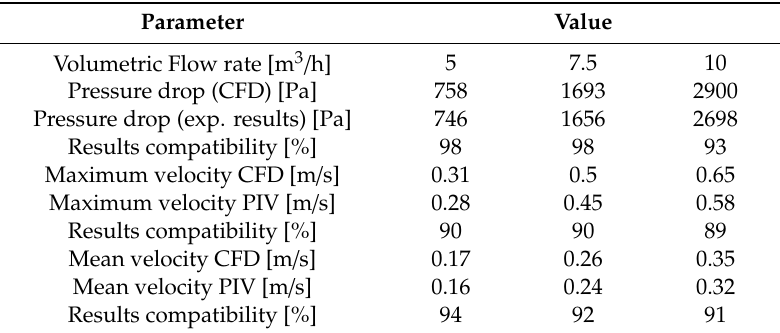
Table 3. Validation of the results.